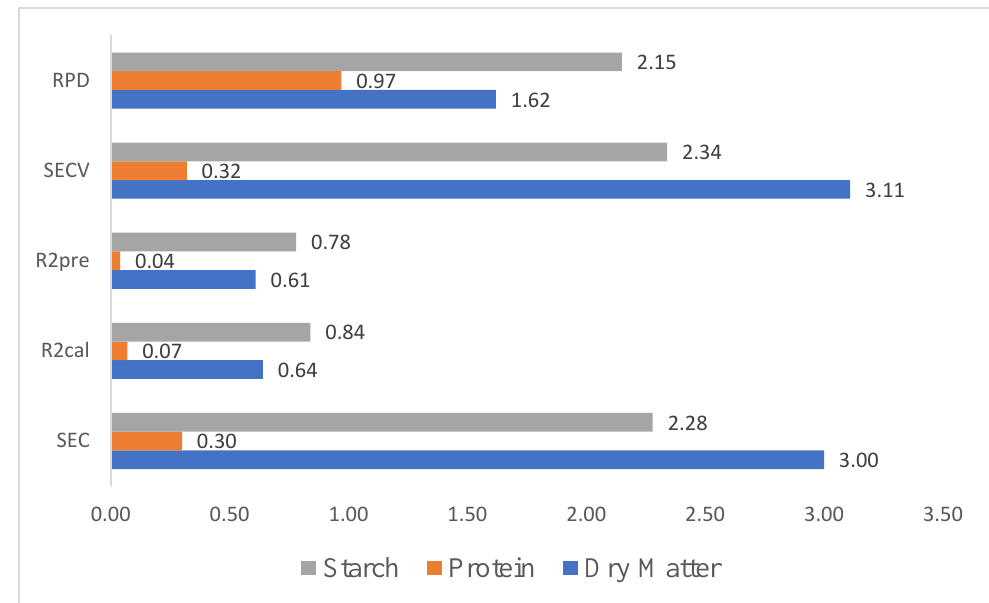
Figure 2. NIRS calibration and validation statistics for chopped fresh yam tubers. SEC : standard error of calibration; RPD : the ratio of performance to deviation; SECV : standard error in cross-validation; R 2Cal : the determination coefficient for calibration; R 2pre : the determination coefficient for prediction.